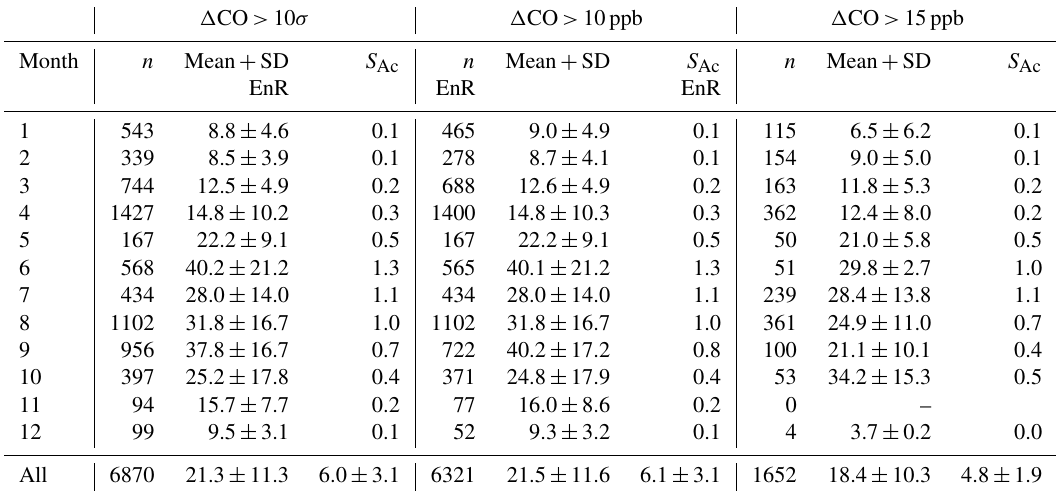
Table B1. Results of three different cut-off requirements (top row) applied to the dataset for North America. For each month and cut-off requirement, the number of unique EnRs ( n ), the mean EnR and standard deviation in pptppb − 1 and the resulting acetone source ( S Ac ) in Tg are provided. The means and standard deviations for all months (last row) are based on the monthly